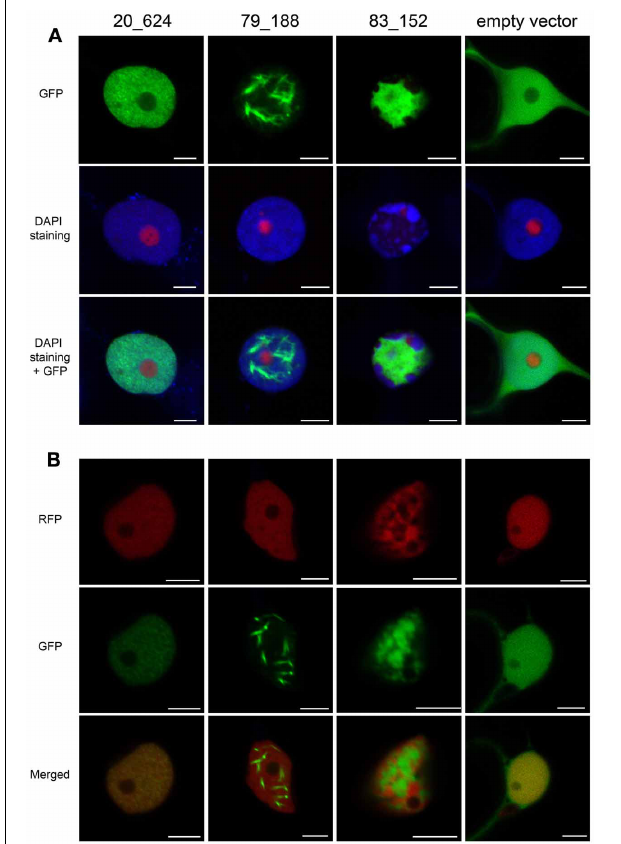
FIGURE 5 | CRN 83_152 causes re-localization of DNA within the nucleus. CRN-GFP fusion constructs were over expressed in N. benthamiana plants and imaged by confocal microscopy 48h post-infiltration. (A) Leaves were co-infiltrated with RFP-fibrillarin and were DAPI stained by infiltrating with 4 (cid:4) ,6-Diamidino-2-Phenylindole dilactate at a final concentration of 5 μ g/ml. (B) N. benthamiana plants stably expressing histone RFP were infiltrated with CRN-GFP fusion constructs as described above. Scale bars = 5 μ m.